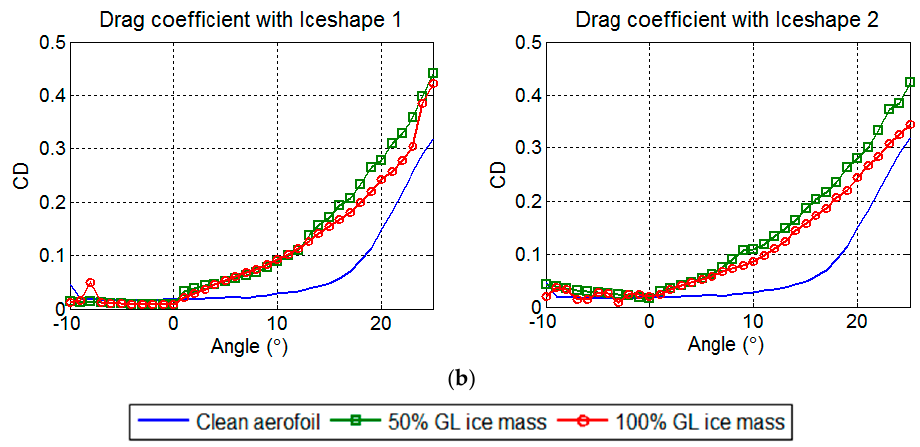
Figure 7. ( a ) Lift and ( b ) drag coefficients of the clean and iced aerofoil NACA 4412 at the blade tip.